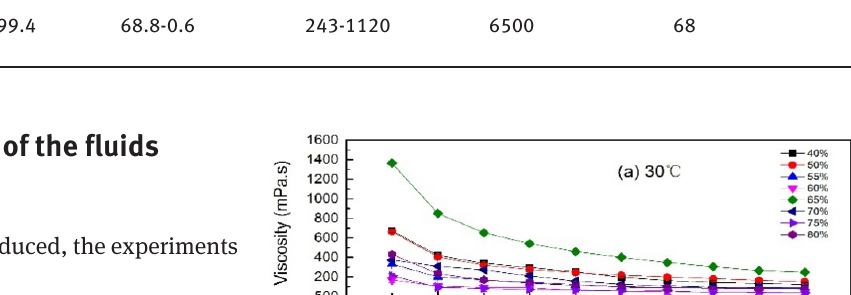
Table 1: The data of the compositions of the fluids produced. Compositions